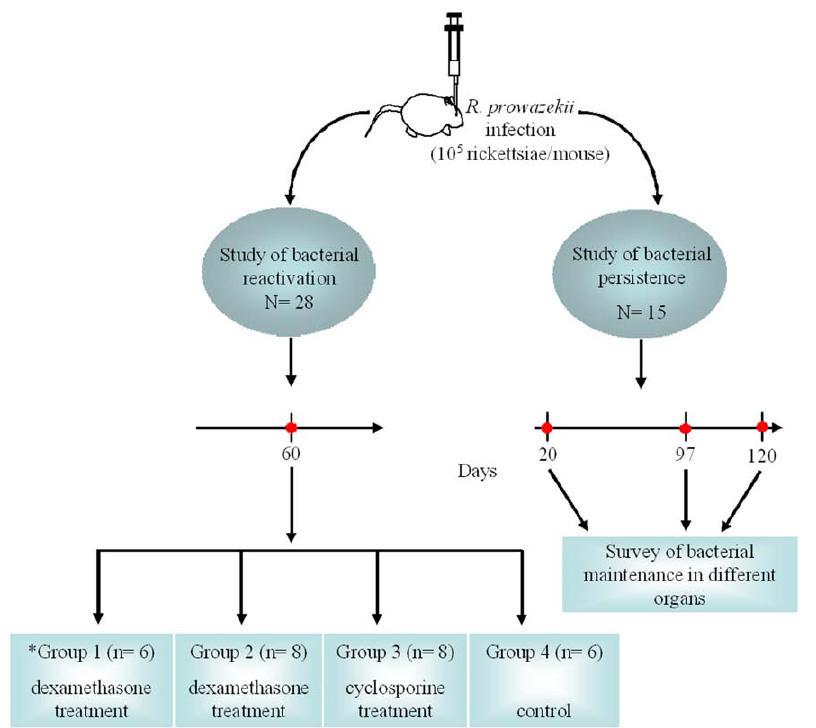
Figure 4. Experimental protocol for study of Rickettsiaprowazekii persistence and reactivation in BALB/c mice. BALB/c mice were infected intravenously (via the retro-orbital venous plexus) with 1 6 10 5 bacteria. Doxycycline was administered to group 1 (*) per os on days 7 and 9. Two months following the primary infection, mice were immunosuppressed with dexamethasone or cyclosporine via the intra-peritoneal route. A control group received sham immunosuppression with phosphate buffered saline. To study bacterial persistence, infected mice were sacrificed at days 20 (n=2 mice), and 97 (n=2) post-challenge and the presence of bacteria in different organs was assessed by PCR, cell culture, and immunostaining. Mice sacrificed at 120 days post-infection (n=11) were infected in a separate experiment and bacterial persistence was evaluated by the same techniques.